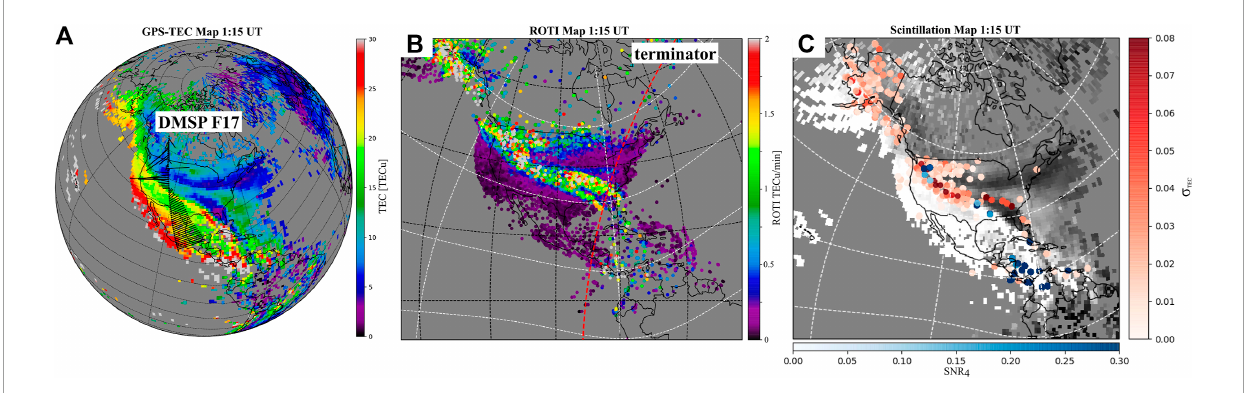
FIGURE 1 Mid-latitude plasma structuring during the 7–8 September 2017 storm at 1:15 UT on 8 September. (A) TEC map showing multiple TEC structures in the NW-SE direction with a DMSP F17 trajectory and the resolved horizontal flow. (B) ROTI maps at the same time. The red dashed line is the location of the sunset terminator. (C) Background TEC (gray) overlaid with proxy scintillation indices, phase (red), and intensity